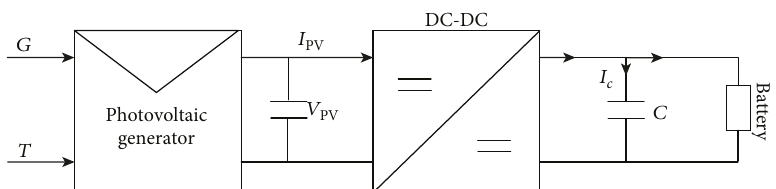
Figure 2: Solar energy conversion system.